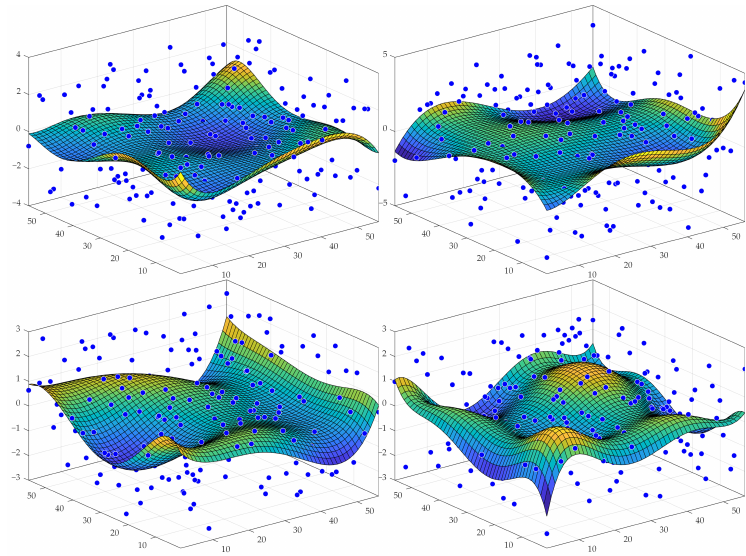
Figure 5. Visualization of the generation of varying background templates. Four samples of back- grounds are presented. Each plot shows a randomly generated grid of points and a fitted polynomial surface of degree 5 in x and y